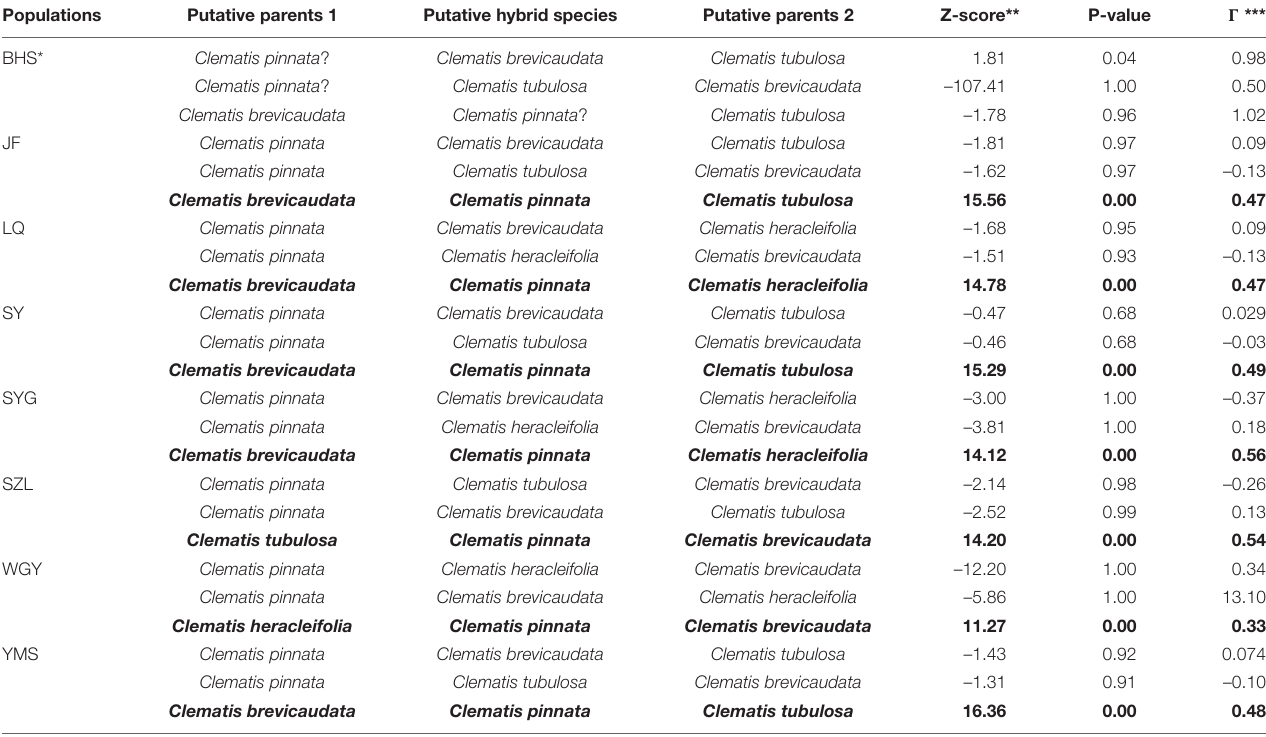
TABLE 3 | HyDe analysis of Clematis pinnata and its putative parents in each population using reduced SNP dataset.